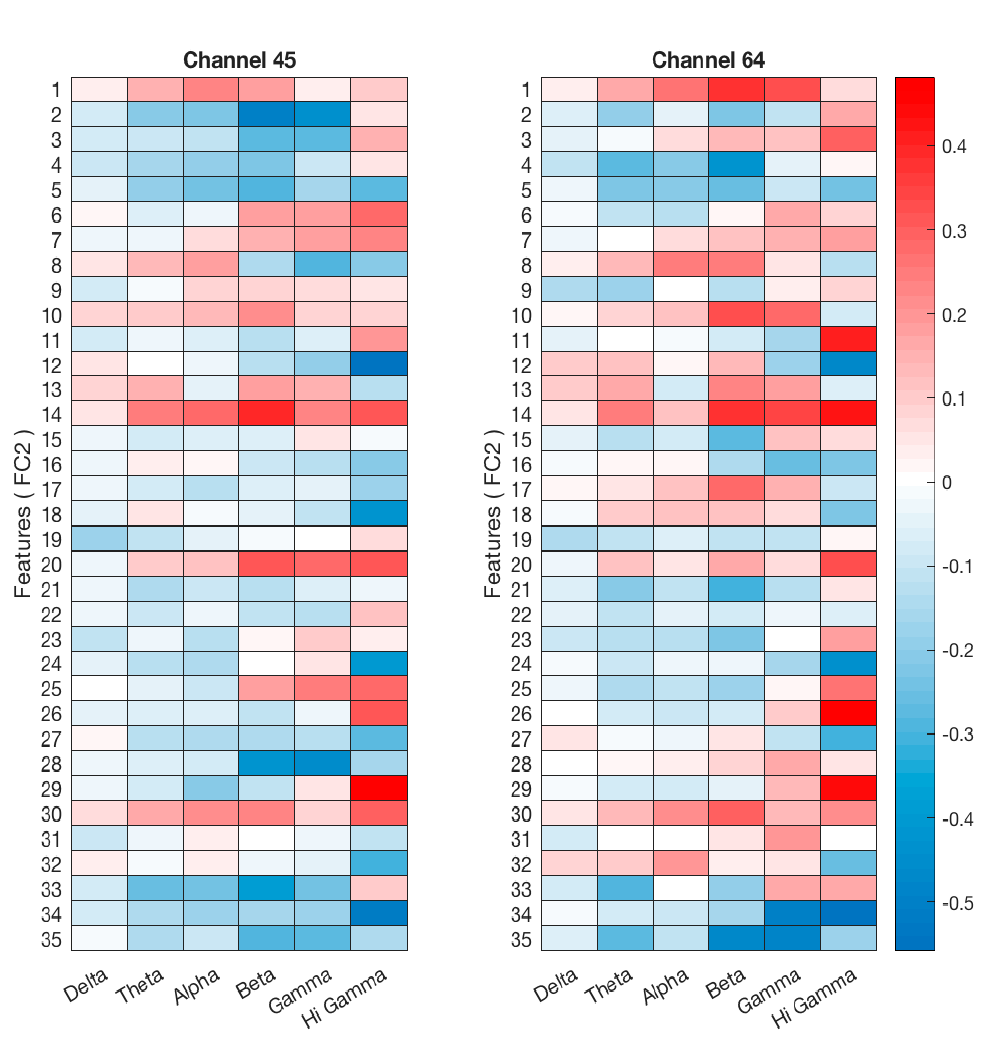
Figure 13. Correlation Coefficients between the EEG Sub-bands and CNN Features. The x-axis represents the frequency bands (Delta, Theta, Alpha, Beta, and Gamma), and the y-axis represents the features extracted from the fully connected layer (FC2).